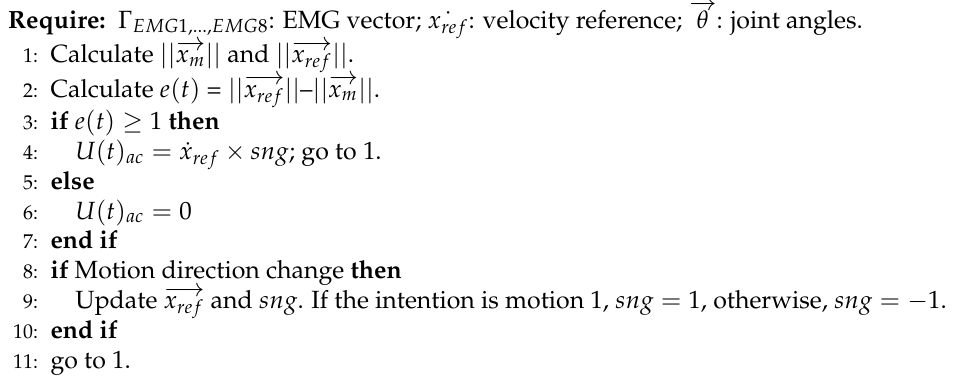
Algorithm 1 Active tracking